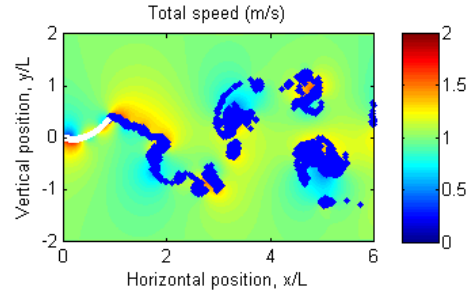
Fig. 13. Instantaneous flow velocity magnitude in the wake.